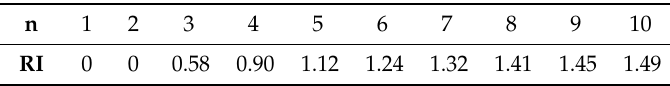
Table 3. Random index